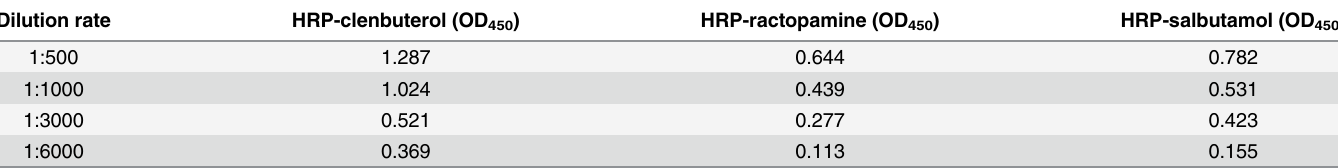
Table 1. Activity assay of recombinant β 2